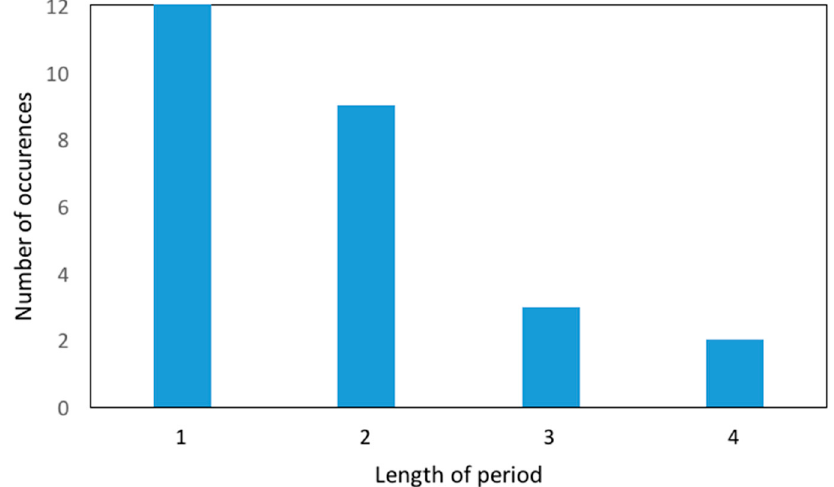
Figure 9. Length of periods with high inflation rates (inflation above 10 per cent) and their frequency of occurrence, based on fitted sample of 1873–2015.